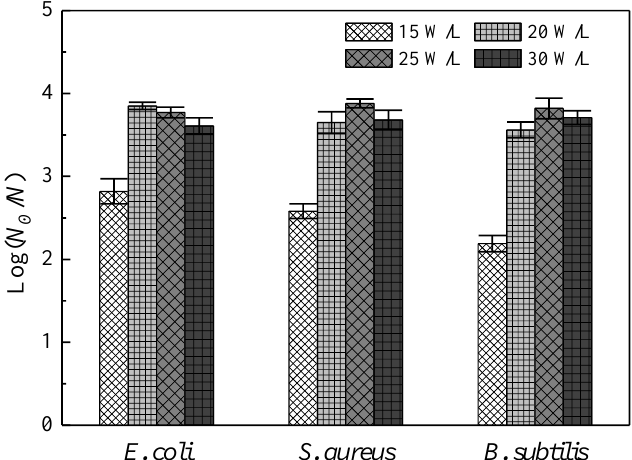
Figure 4. Log inactivation ratio of 10 min 8 mg/L NaClO disinfection following 17 + 30 kHz dual-frequency US pretreatment under different US input power densities. Error bars correspond to standard error of three replicate experiments.